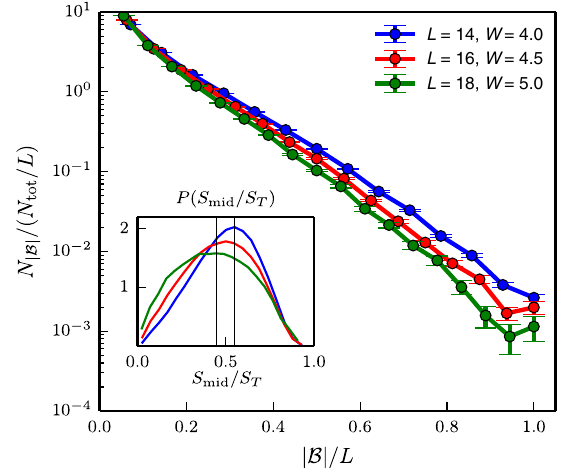
FIG. 8. Distribution of thermal block sizes for eigenstates with 0 . 45 < S < 0 . 55 . The exponential decrease in N mid suggests that the local entanglement structure in these states looks inhomogeneous with a network of small interspersed thermal and localized blocks. Inset: Distributions for S for different L ’ s and W ’